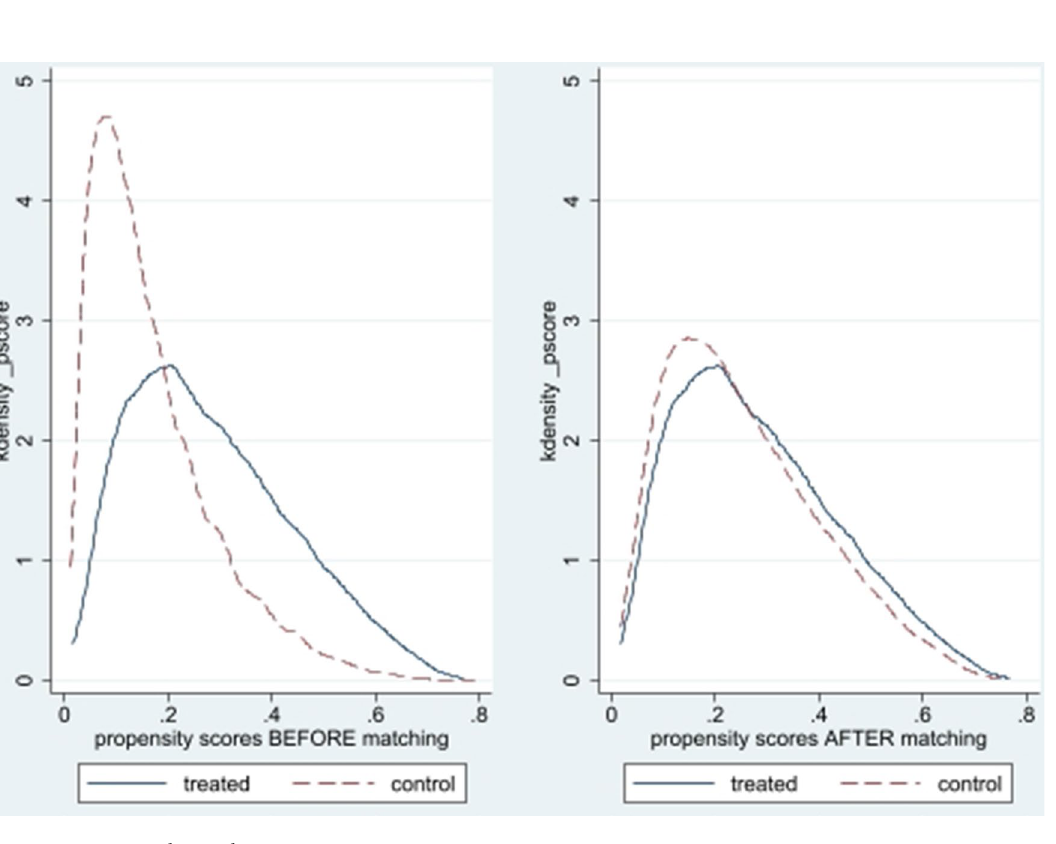
Figure 1. Balance